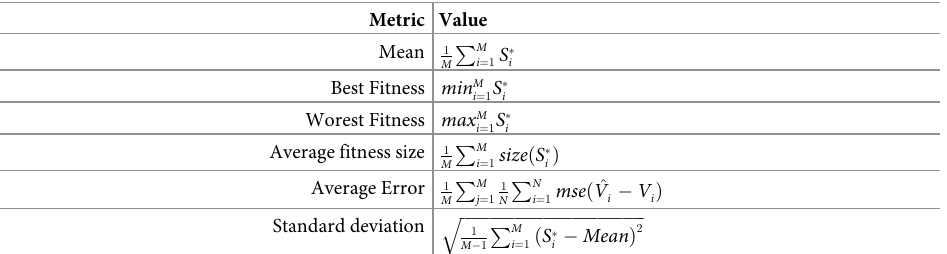
Table 2. Evaluation metrics used in assessing the proposed feature selection method.